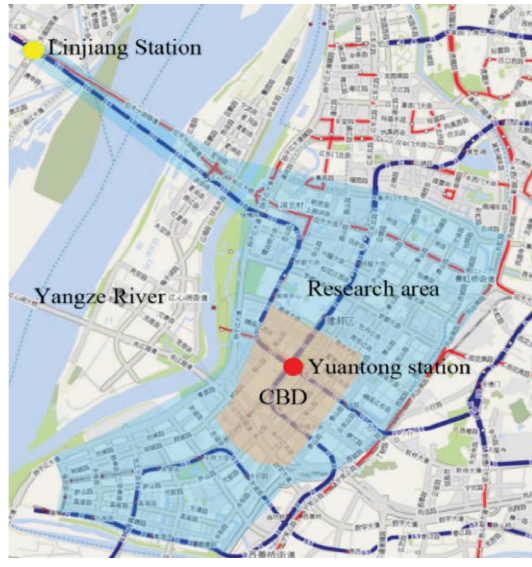
Figure 11: Research